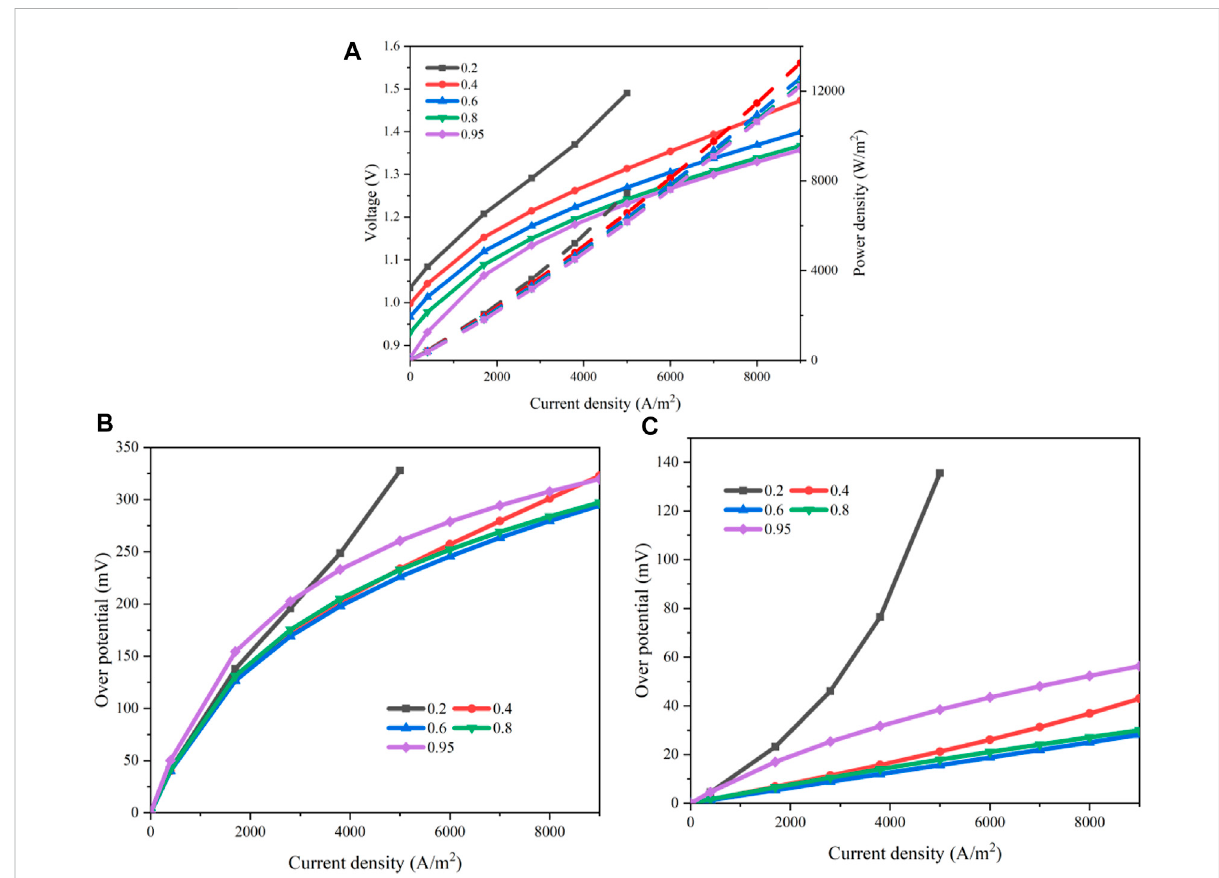
FIGURE 10 Effects of the steam concentration: (A) polarization curve; (B) activation overpotential; (C) concentration